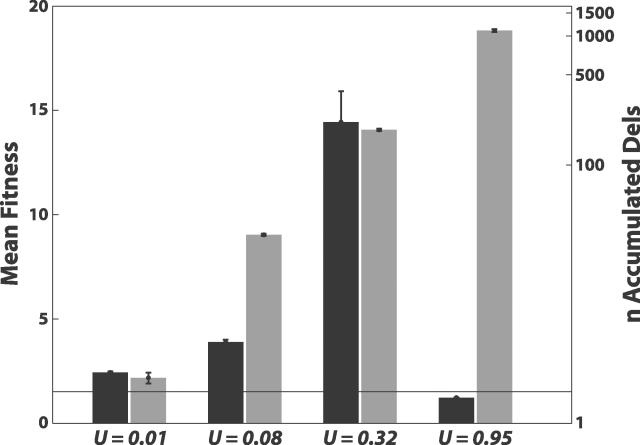
The Mean Fitness of Evolved Populations Increases with Mutation Rate (up to U = 0.32) despite Accumulating Greater Numbers of Deleterious MutationsThe dark gray bars (left) represent the mean final fitness of populations that evolve under each mutation rate. The light gray bars (right) show the mean number of deleterious mutations that accumulate during the time to the MRCA of the final population. The error bars represent one standard error from the sample mean.